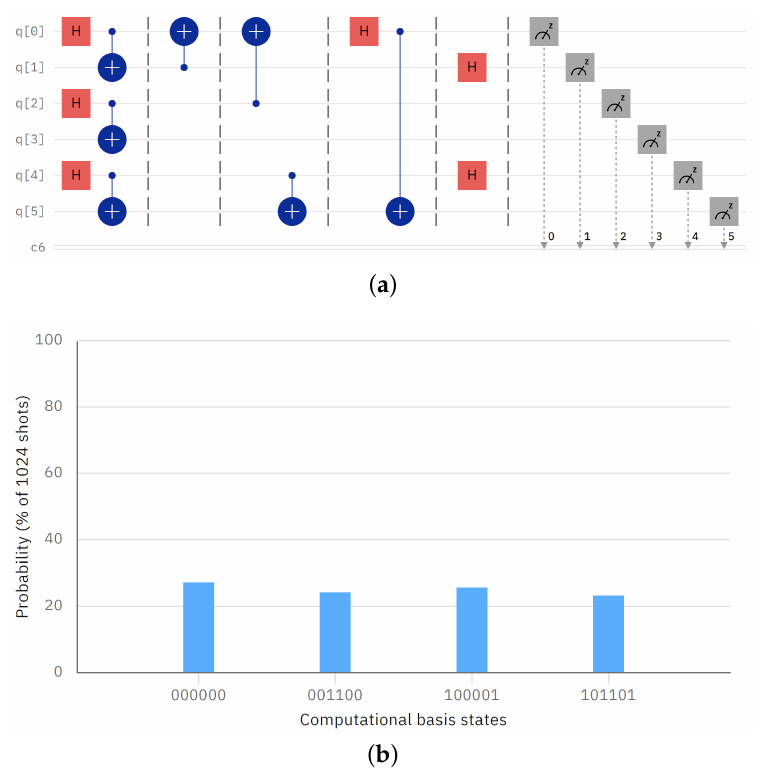
Figure 4. Generating cluster states through 4-step multi-coin quantum walk: ( a ) Quantum circuit generating cluster states and ( b ) simulation